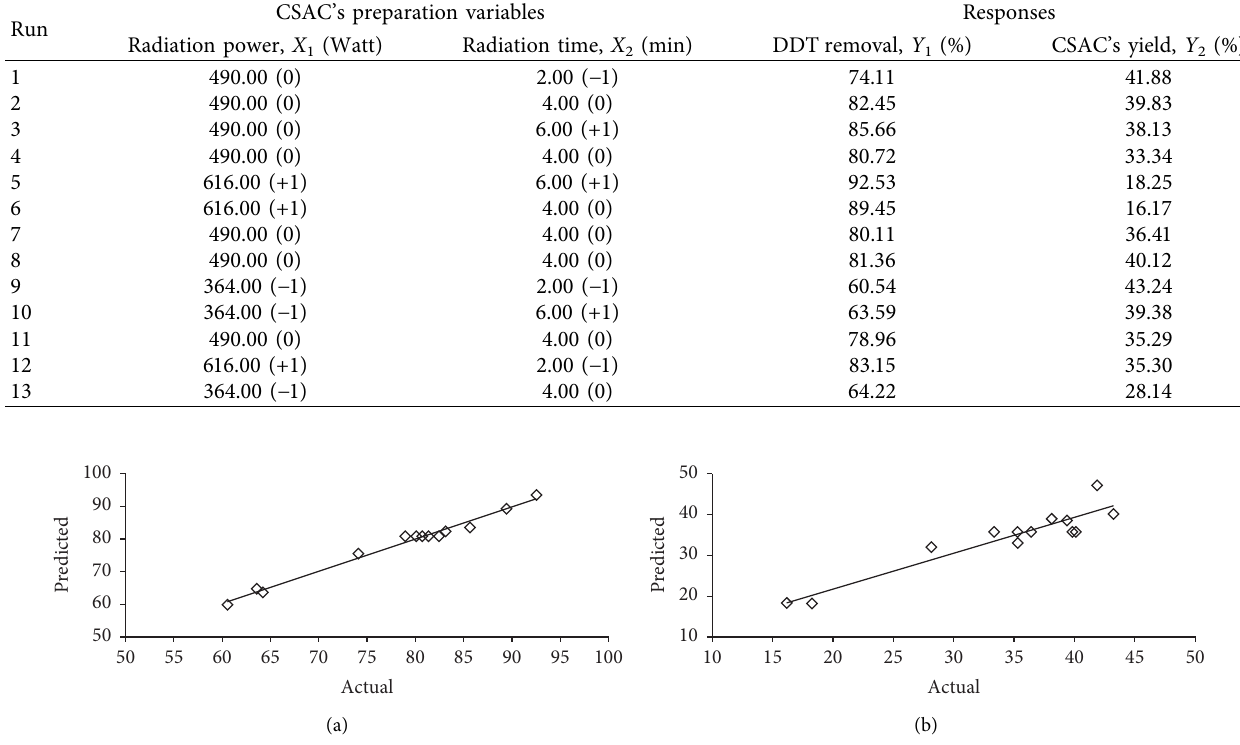
Figure 7: Plot of predicted versus actual (a) DDT removal and (b) CSAC’s